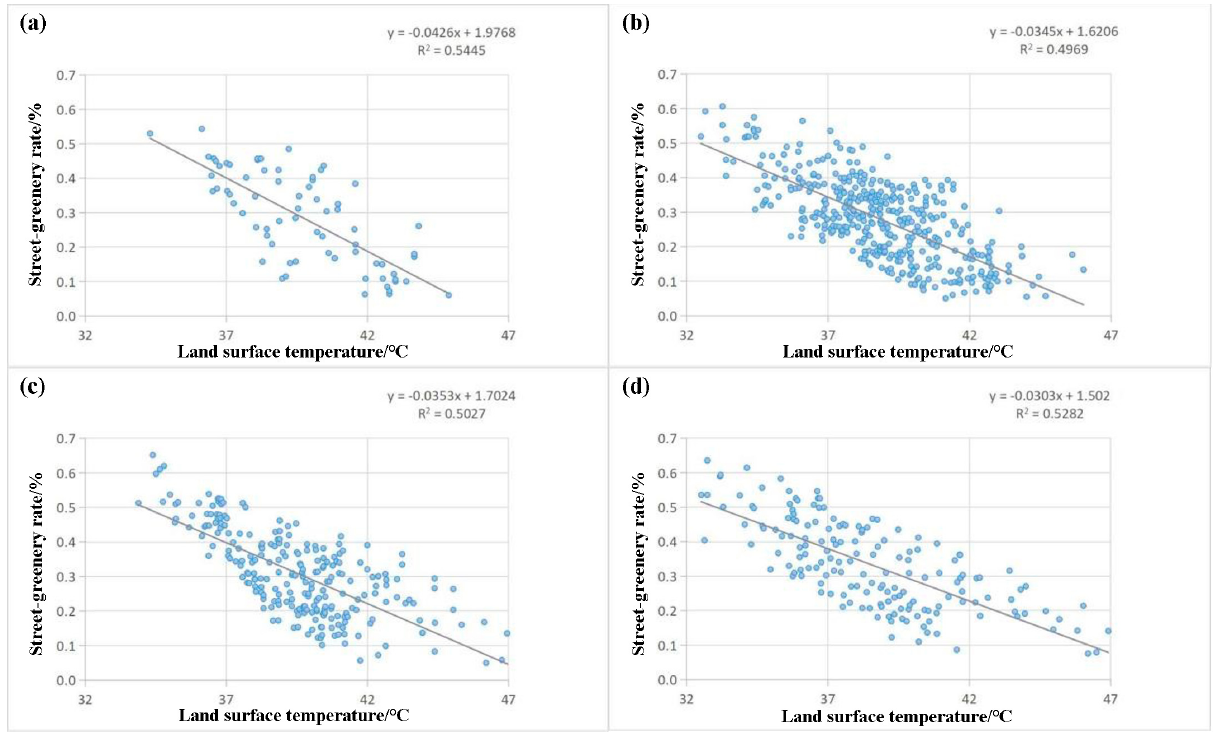
Figure 12. Relationship between the streets SGR and LST of different types in multi-rise and low-density built-up areas, ( a ) Expressways; ( b ) Main trunk roads; ( c ) Secondary trunk roads; ( d ) Branch